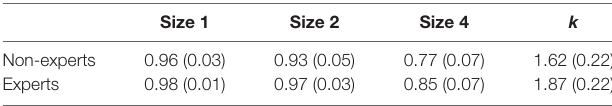
TABLE 1 | Descriptive behavioral results in both experts and